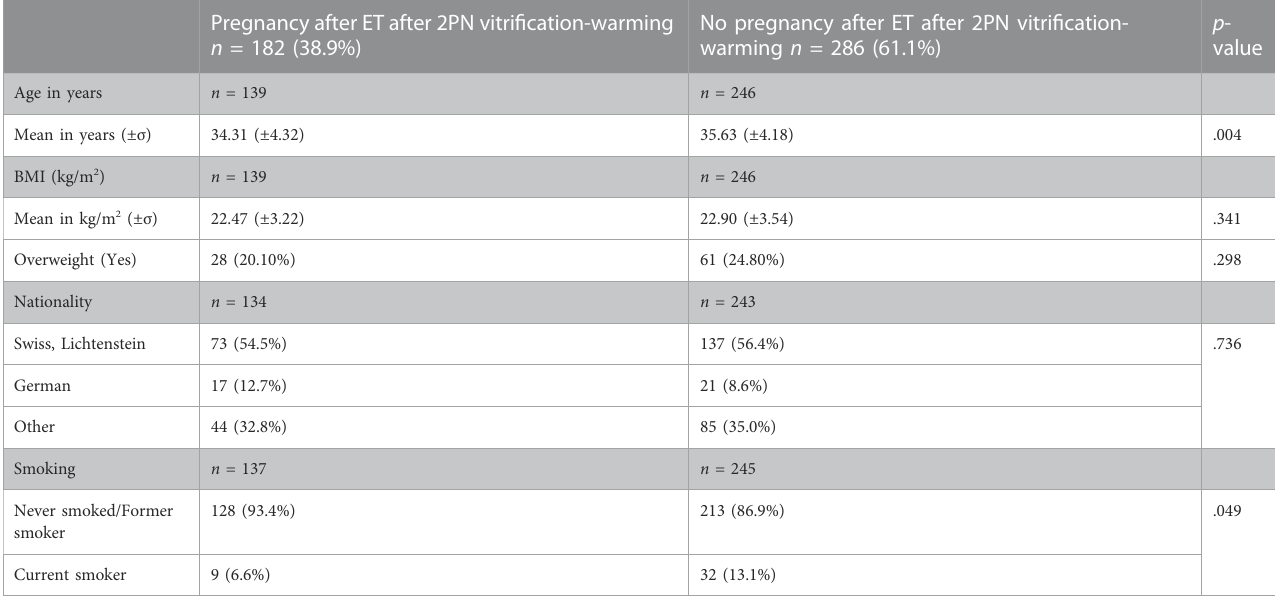
TABLE 1 Socio-epidemiologic characteristics of